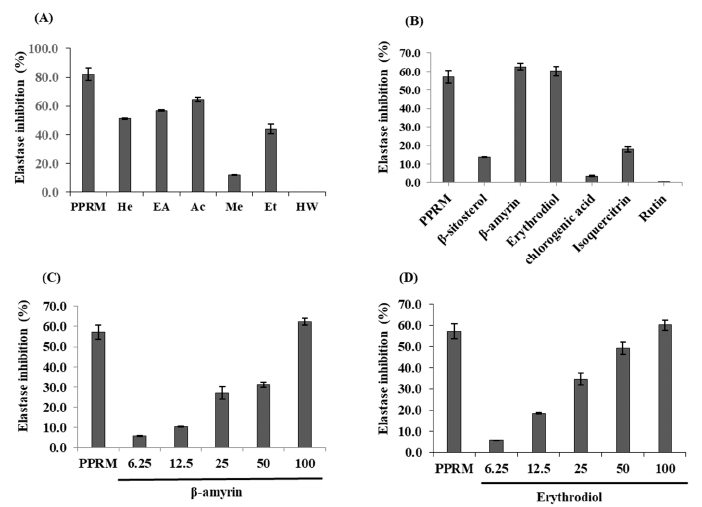
Figure 2. Elastase inhibition of IW extracts and biomarkers derived from IW extract: ( A ) elastase inhibitory activities in various solvent extracts of Ilex x Wandoensis (0.5 mg/mL); ( B ) elastase inhibitory activities of six biomarkers (0.1 mg/mL); ( C , D ) elastase inhibitory activity of β‐ amyrin and erythrodiol. The positive control was Phospharamdion (0.1 mg/mL).